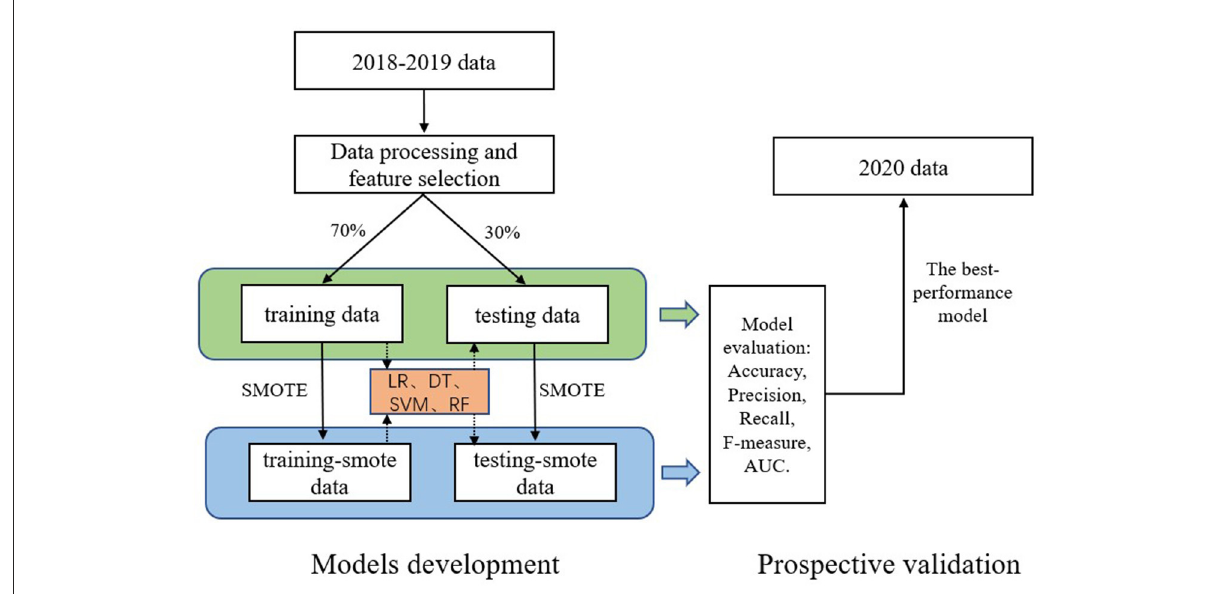
FIGURE1 Flow chart of models development and prospective validation. LR, logistic regression; DT, decision tree; SVM, support vector machines; RF, random